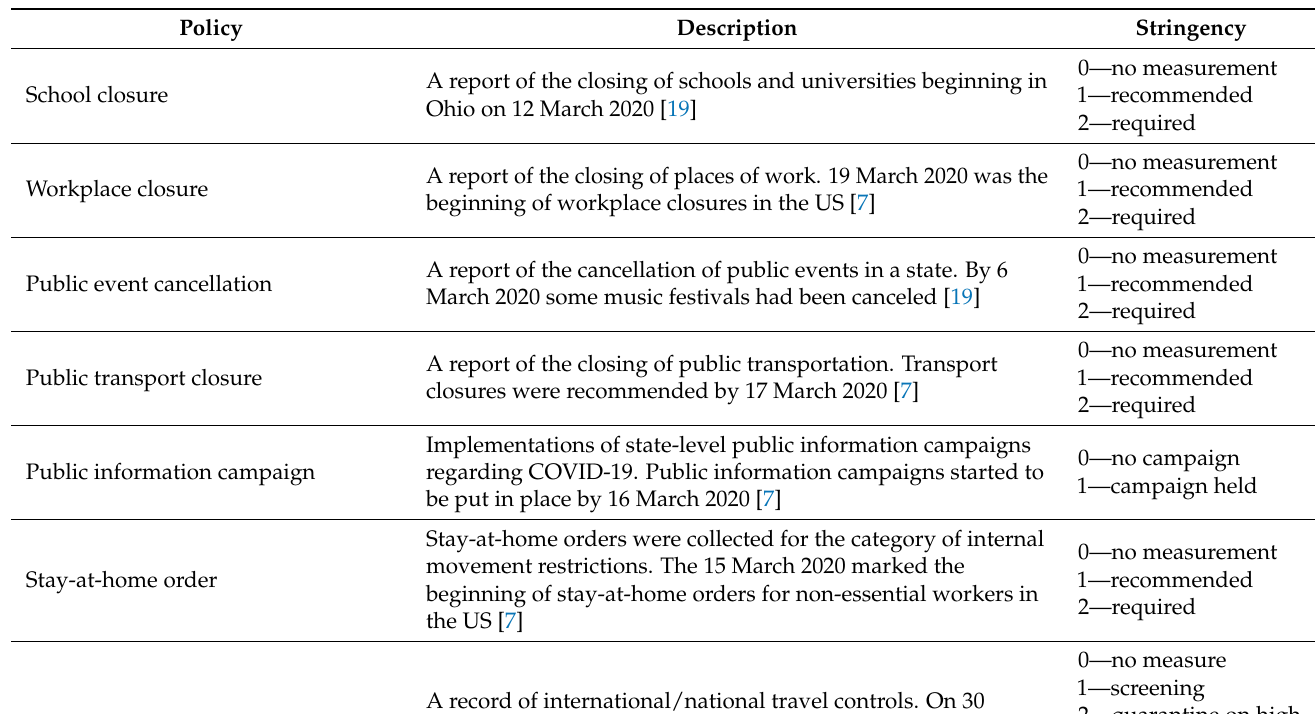
Table 1. State-level policy data in the